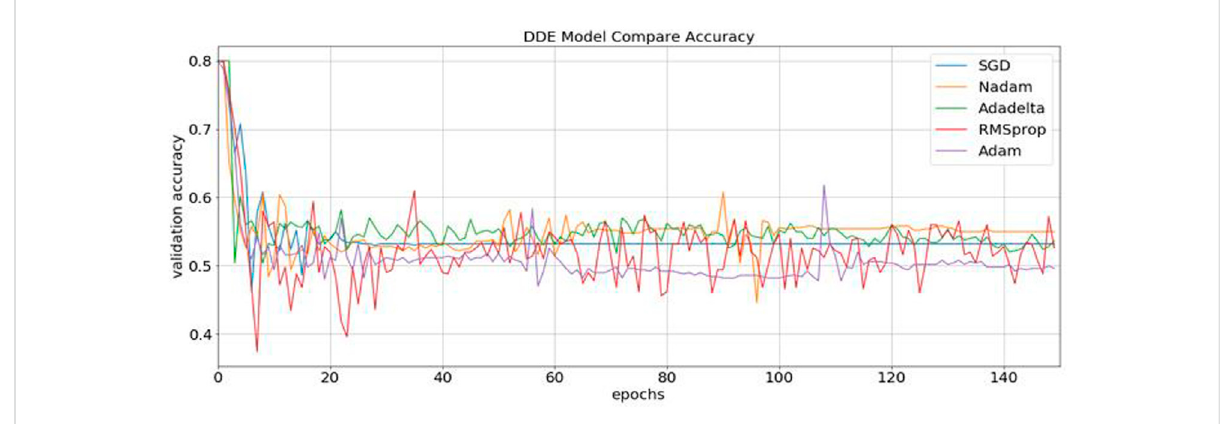
FIGURE 3 Identi fi cation of the validation accuracy of the ubiquitin protein pathway based on different optimizers ranging from 0 to 150.